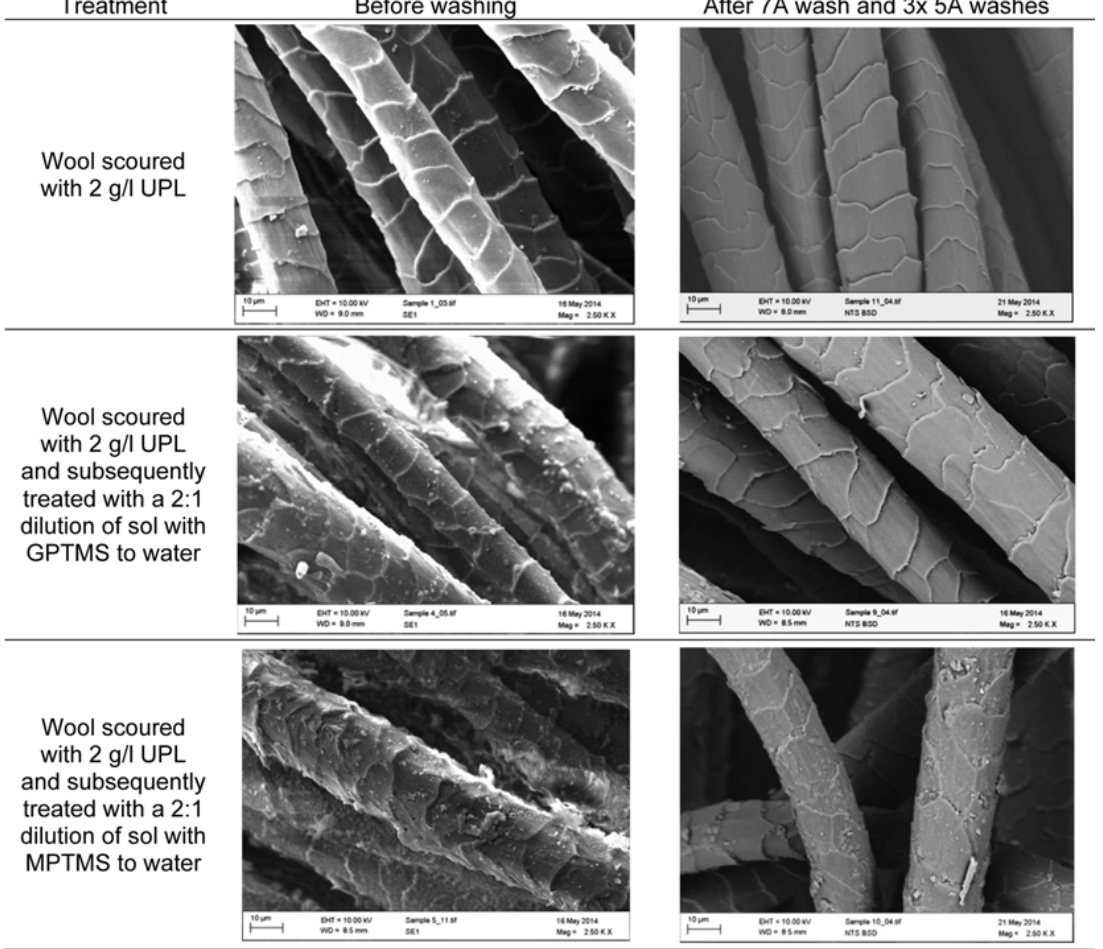
Figure 24. SEM images of wool scoured with 2 g/L UPL then followed by treatment with a 2:1 dilution of sol-gel containing either GPTMS or MPTMS: before washing and after 7A and 3 × 5A washes (Reproduced from [164], with kind permission of Springer).